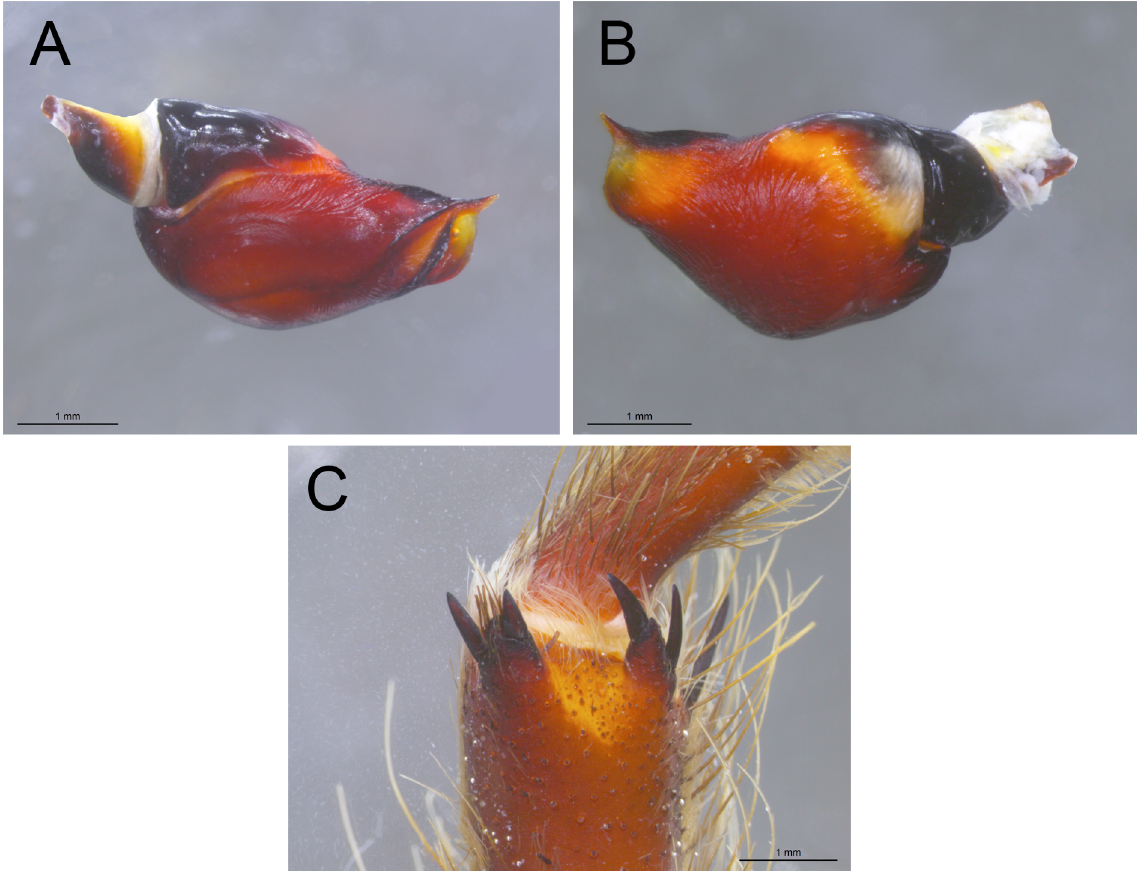
Fig. 9. Umbyquyra sapezal gen. et sp. nov., holotype, ♂, Sapezal, Mato Grosso (IBSP 113753). A . Palp prolateral. B . Retrolateral. C . Tibial apophysis,